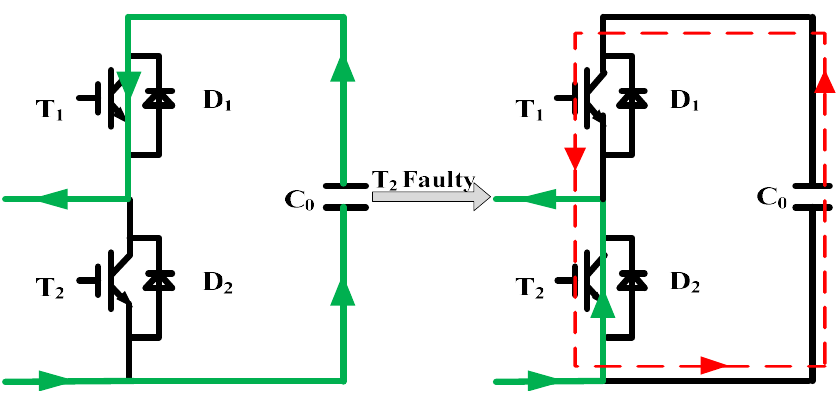
Figure 5. Current path when T 2 is short-circuit with i arm < 0 and S = 1.